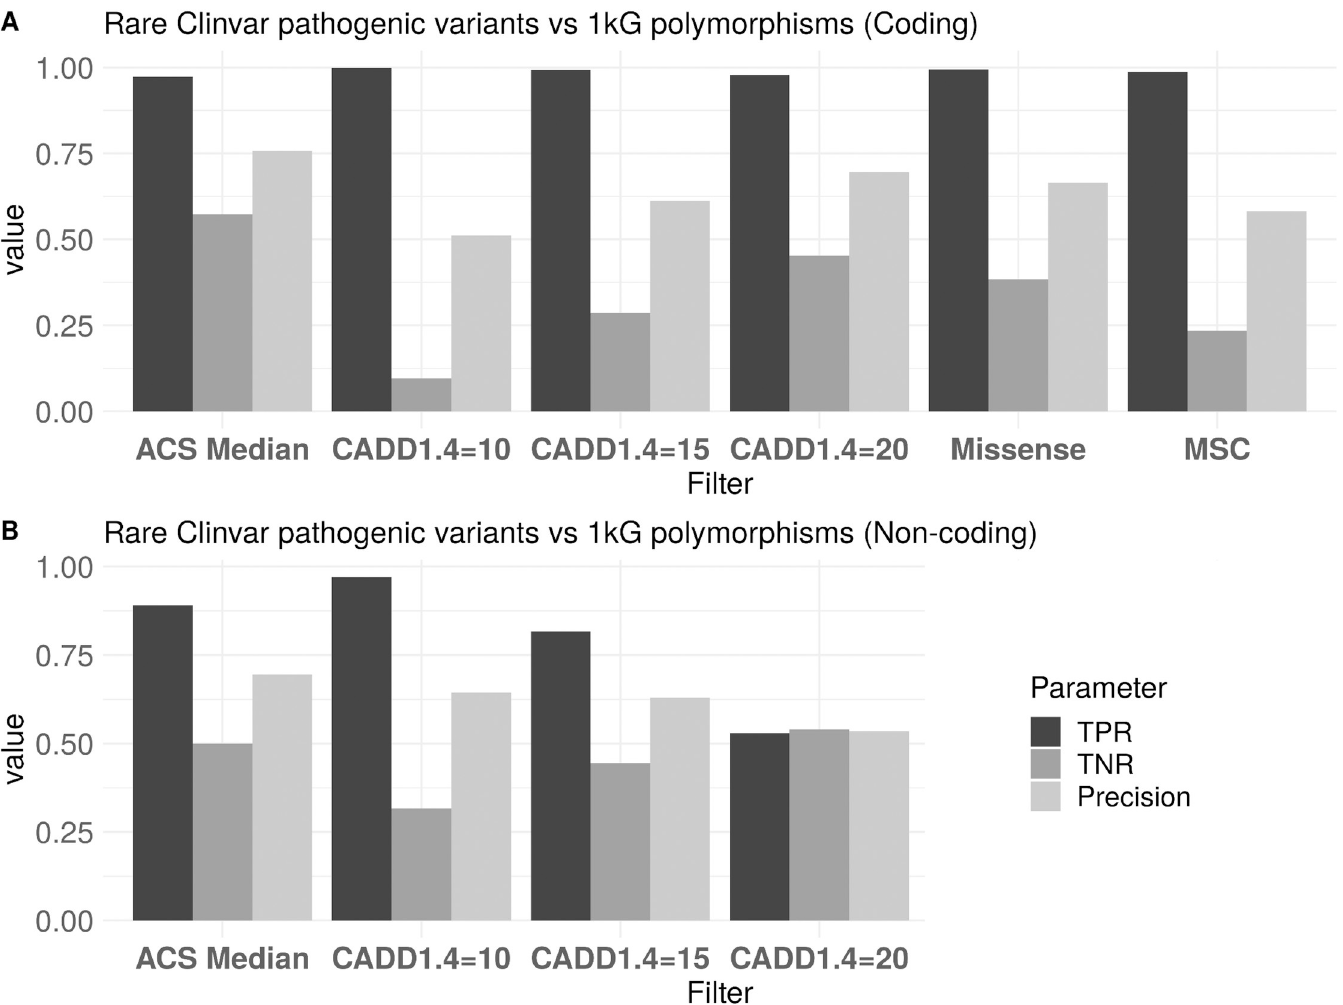
Fig 2. TPR, TNR and precision of different filtering strategies on the Clinvar coding or non-coding variants pathogenic variants compared to rare 1000Genome polymorphisms.